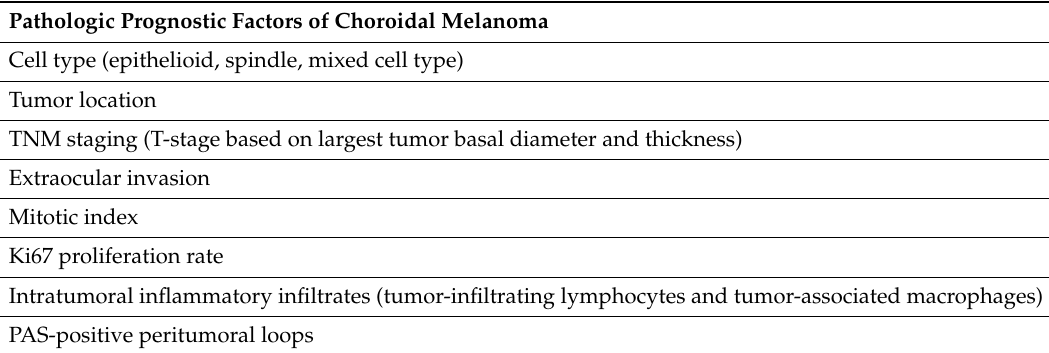
Table 2. Main histologic findings with prognostic value in choroidal